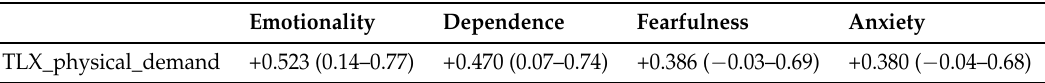
Table 3. Correlations between personality traits and the TLX scores for the CogLoad dataset with 95% confidence interval in parentheses.